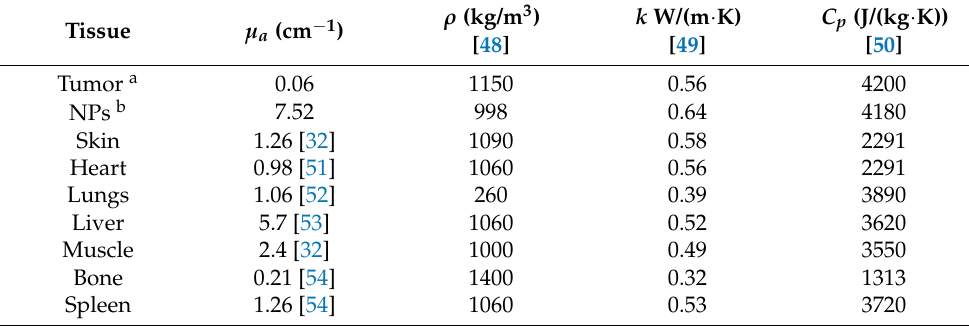
Table 3. Tissue properties of the simulation model.